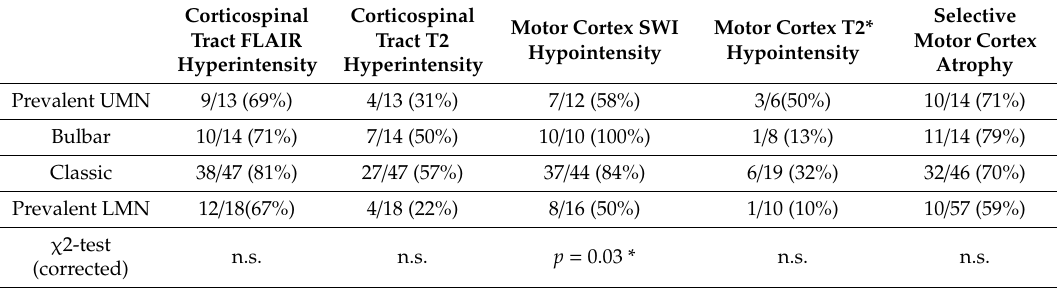
Table 3. Comparison of the prevalence of MRI features among di ff erent ALS